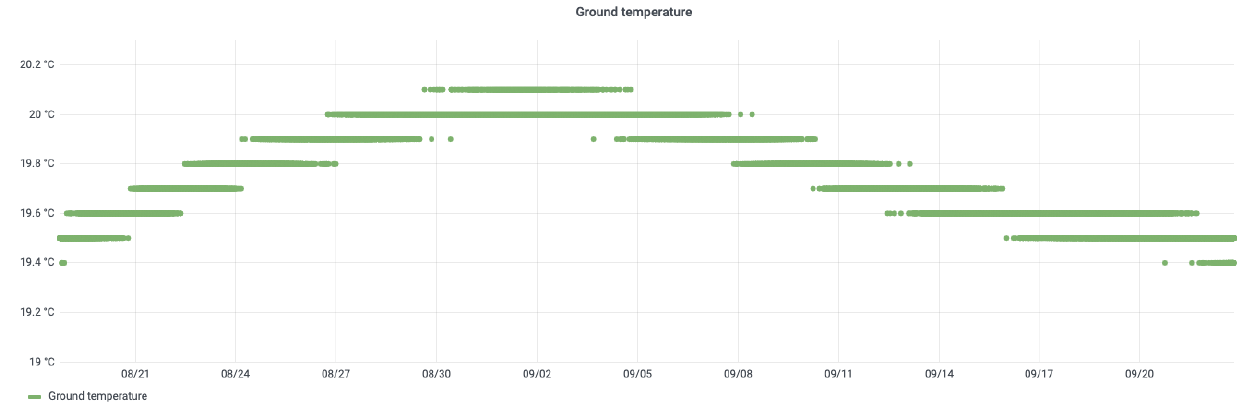
Figure 7. Ground temperature variation for 30 days at a depth of 1.8